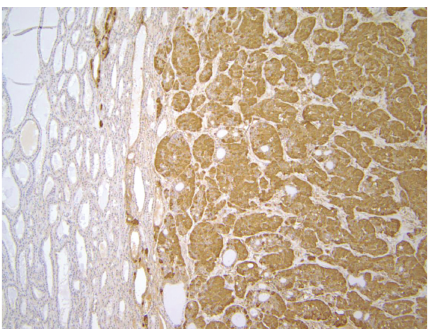
Figure 4: Chromogranin A immunostain on parathyroid tissue. There is diffuse strong cytoplasmic staining of the neoplastic cells. Adjacent thyroid follicles are negative for immunostaining of chromogranin